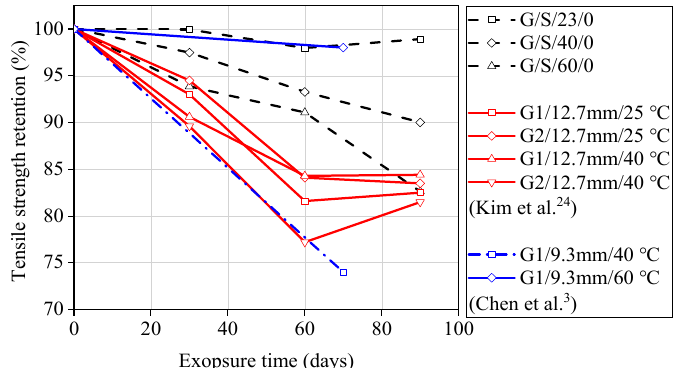
Figure 5. Comparison of experimental data (GFRP bars exposed to seawater solution) from this study and previous literature.